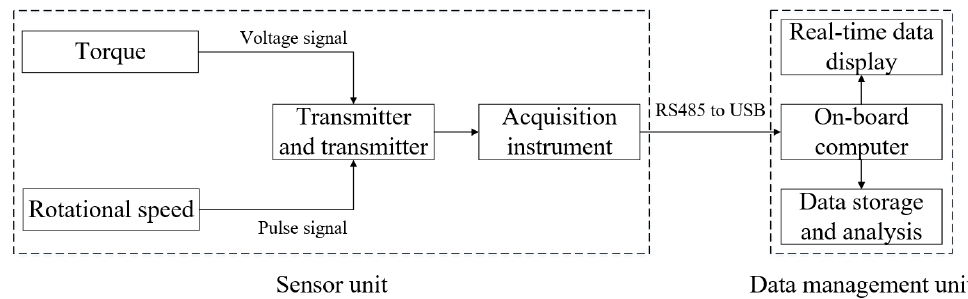
Figure 2. Structural block diagram of a monitoring system.